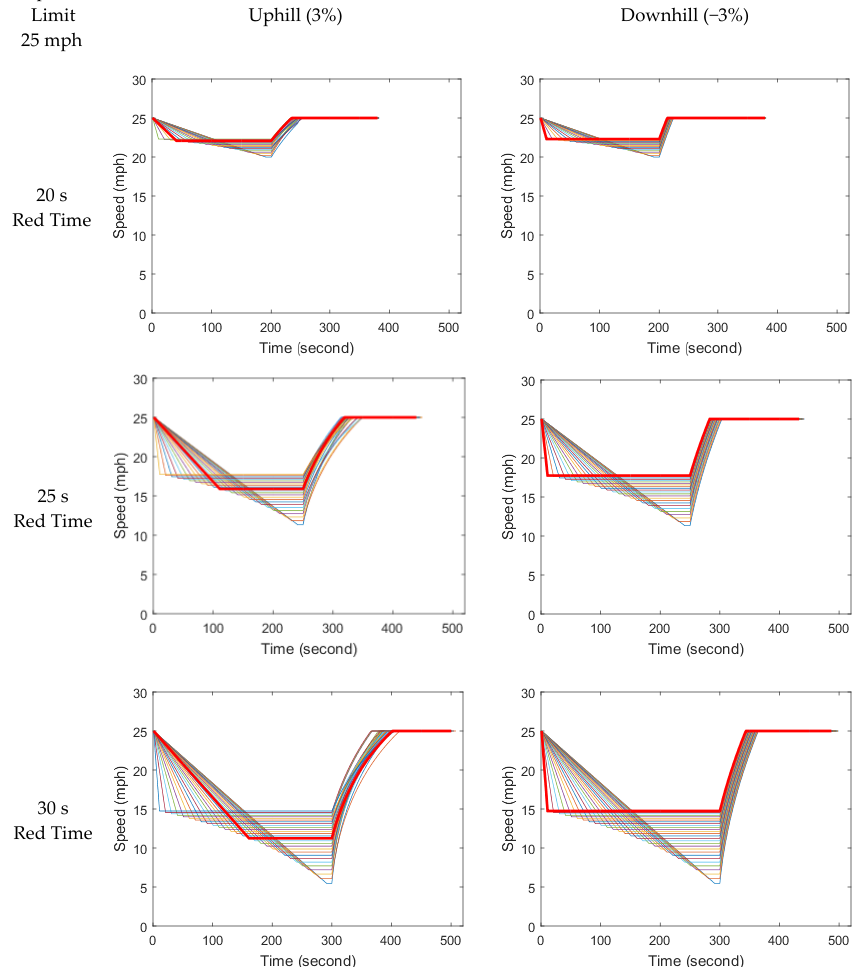
Figure 4. Honda Fit speed profile by ICEV Eco ‐ CACC ‐ I for a speed limit of 25 mph.